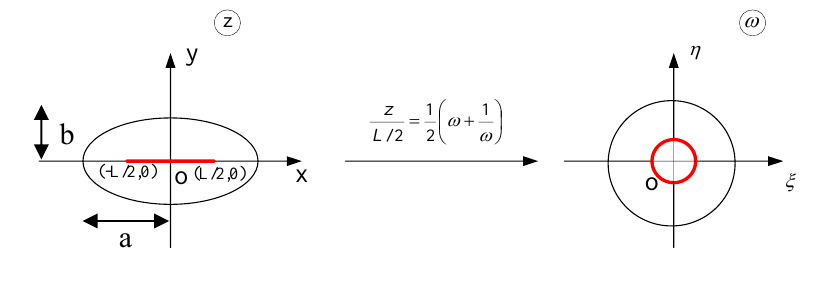
Figure 2—Scheme of horizontal conformal